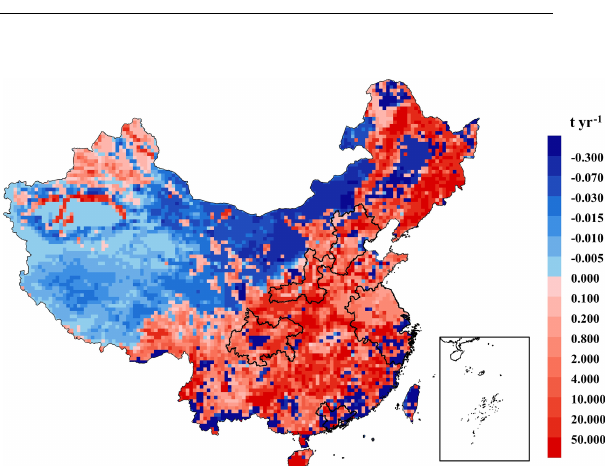
Figure 2. Spatial distribution of interannual variations in BVOC emissions caused by leaf biomass